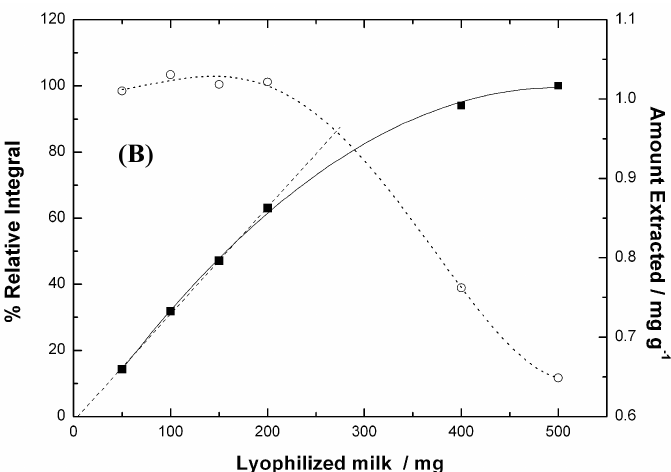
Figure 45. ( A ) Comparison of various extraction methods in respect to the total (9- cis , 11- trans ), (9- trans , 11- cis ) and (9- cis , 11- cis ) 18:2 CLA isomers and caproleic acid integrals. ( B ) Efficiency of the extraction of the milk lipid fraction using the Bligh and Dyer 1:2 method in respect to mg of lyophilized milk sample; ( (cid:4) ), the relative integrals of the composite (9- cis , 11- trans ), (9- trans , 11- cis ) and (9- cis , 11- cis ) 18:2 CLA isomers in respect to the standard reference compound as above. ( ), the amount of the (cid:35)